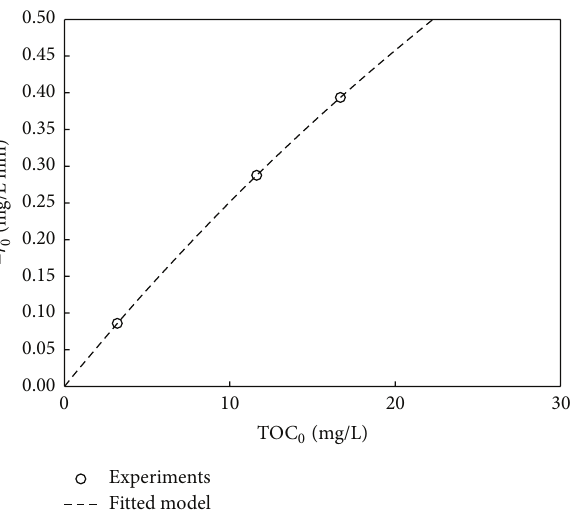
Figure 2: Initial concentration effect on the initial reaction rate of DCA.